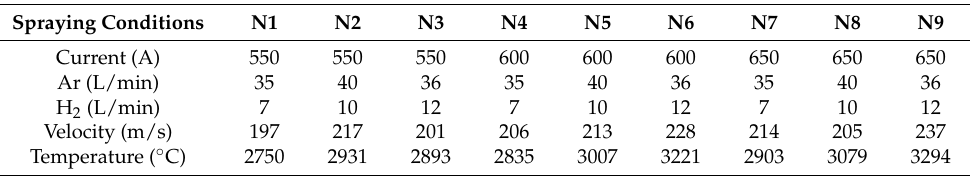
Table 1. Plasma spray parameters and particle velocity, temperature.